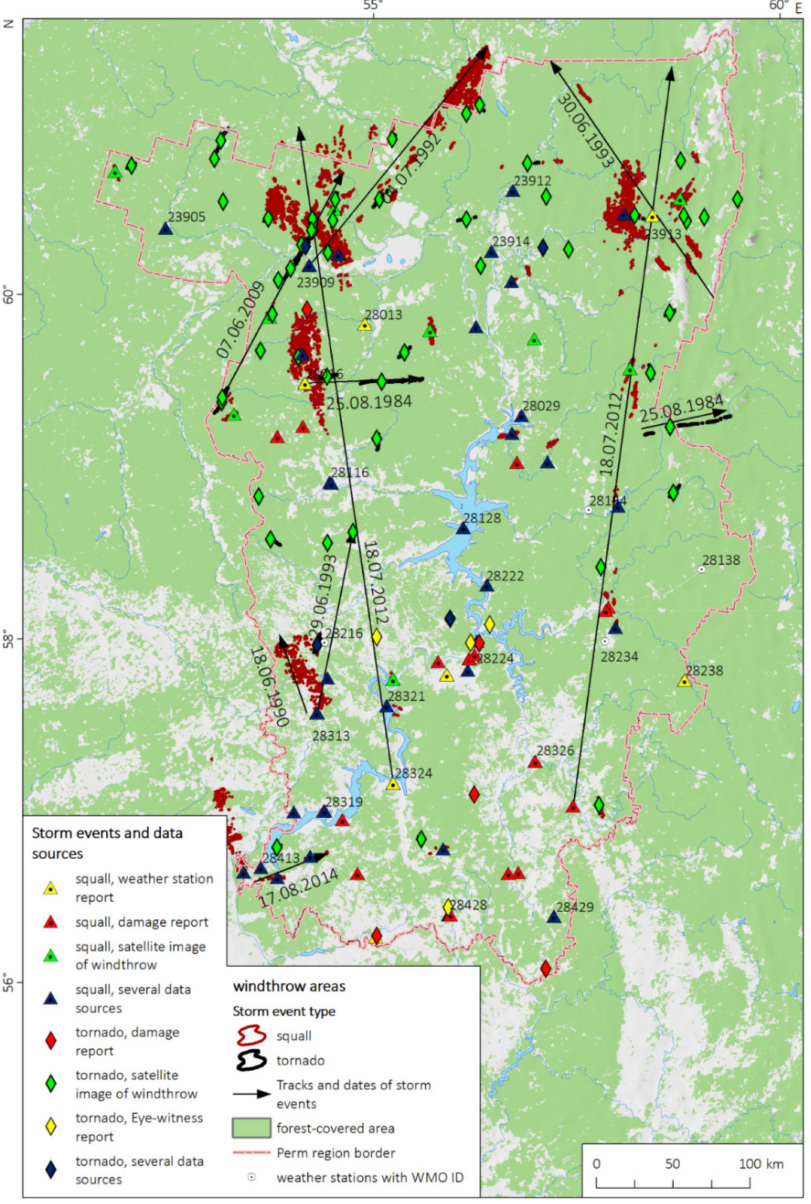
Figure 3. Spatial distribution of the storm reports and windthrow areas in PR (1984–2020). Note, that one point may correspond to several storm events observed at a weather